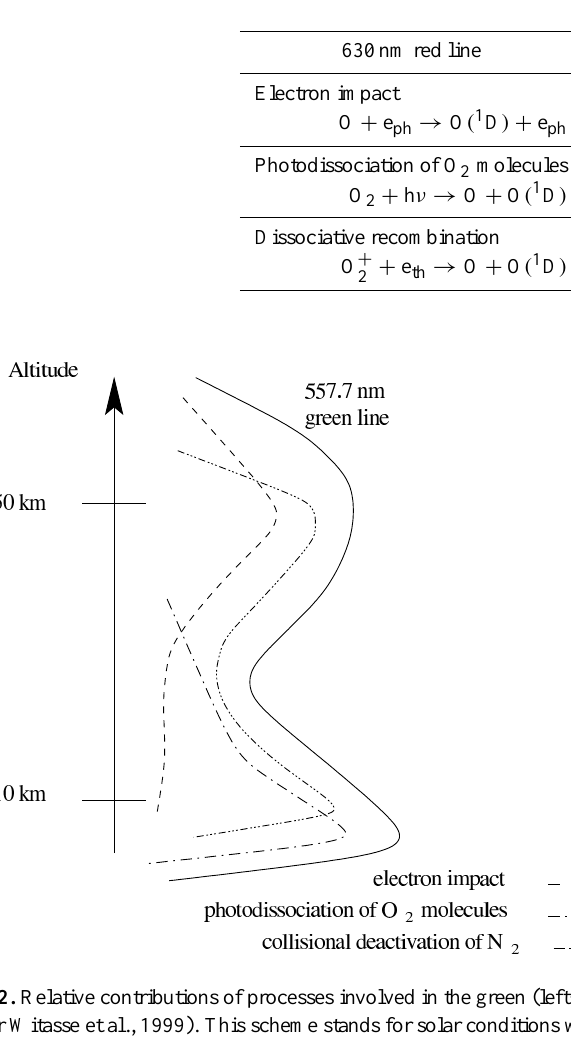
Table 1. Main production processes used in TRANSCAR for the red and green atomic oxygen lines.